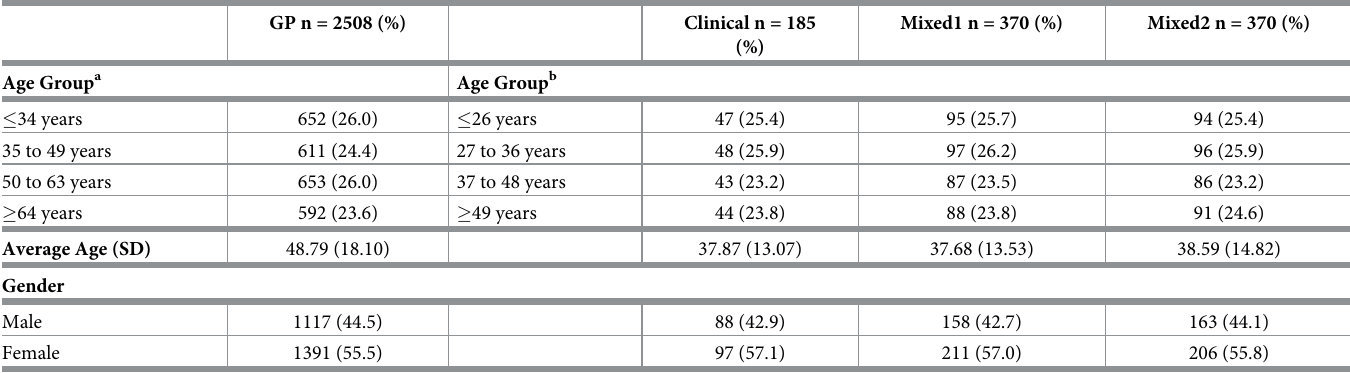
Table 1. Characteristics of the study